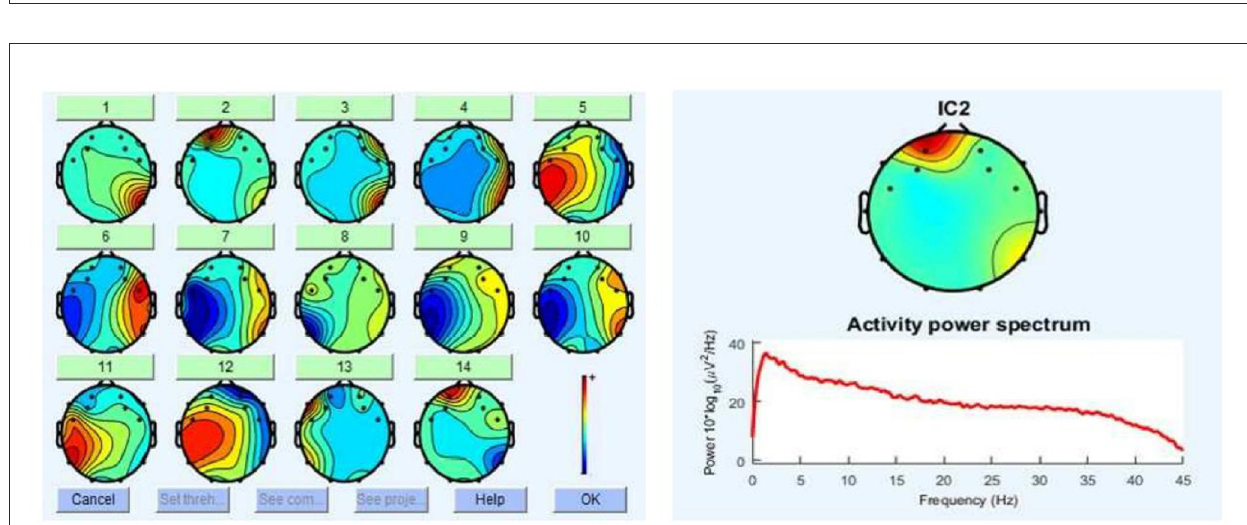
FIGURE5 (Left) Topographic maps using independent components analysis (ICA). The spatial topography of each component represents its distribution in the different electrodes. This contribution is shown in scale of colors that reflect the energy in each brain area. (Right) Independent component detected as a potential artifact by the automatic algorithms, ADJUST Mognon et al. (2011) implemented in EEGLAB. Top is shown the spectral contribution of component in the brain topography and down is shown the associated power spectrum.